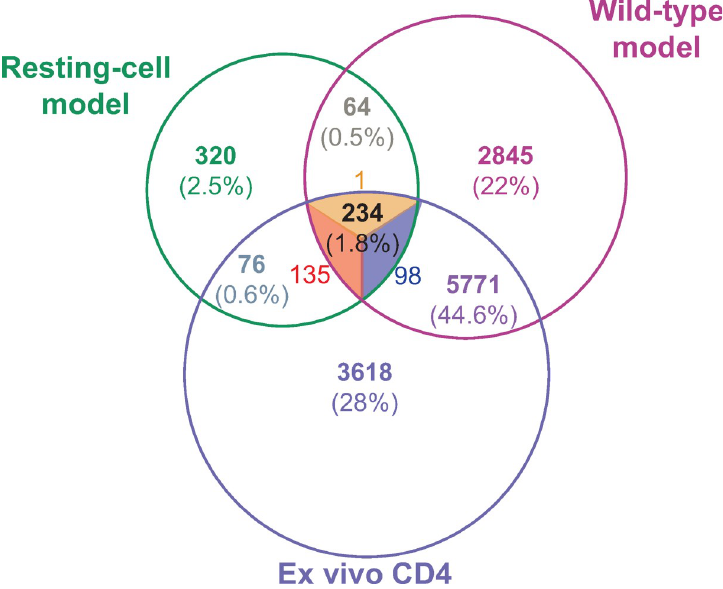
Fig 6. Transcriptome analysis of the Resting-cell model, Wild-type model, and cells from ART-suppressed individuals. Venn diagram showing the number of differentially expressed genes between unstimulated and stimulated peripheral CD4 + T cells from the Resting-cell model, the Wild-type model (infection using wt NL4.3 HIV and no raltegravir), and ART-treated individuals (2 donors/model). Up-regulated genes are shown in red, down- regulated in blue, and discordant genes in